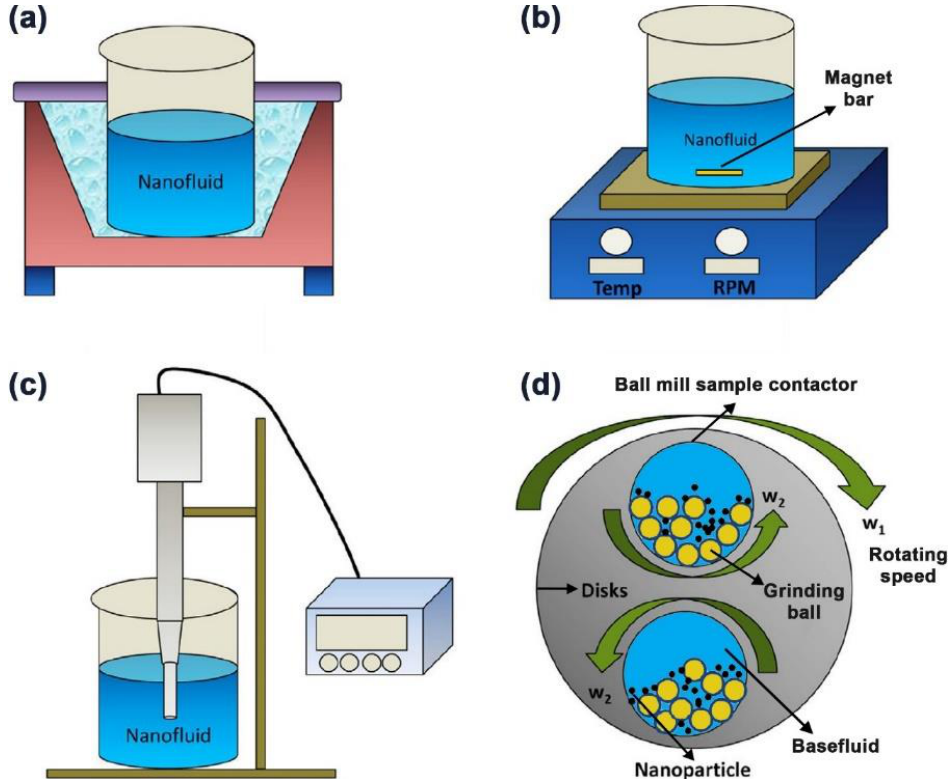
Figure 14. Physical dispersion stability enhancement devices, where ( a ) shows the ultrasonic bath sonicator, ( b ) demonstrate the magnetic stirrer, ( c ) illustrates the homogenizer/prob sonicator, and ( d ) shows the ball milling device. Reproduced with permission from [116]. Elsevier, 2020.